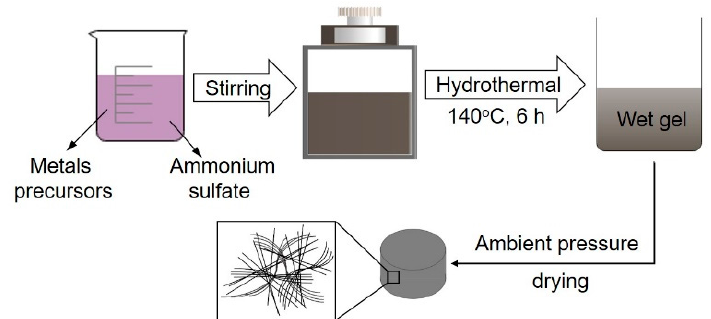
Figure 1. The schematic diagram of the preparation process for macroscopic self-standing architectures.